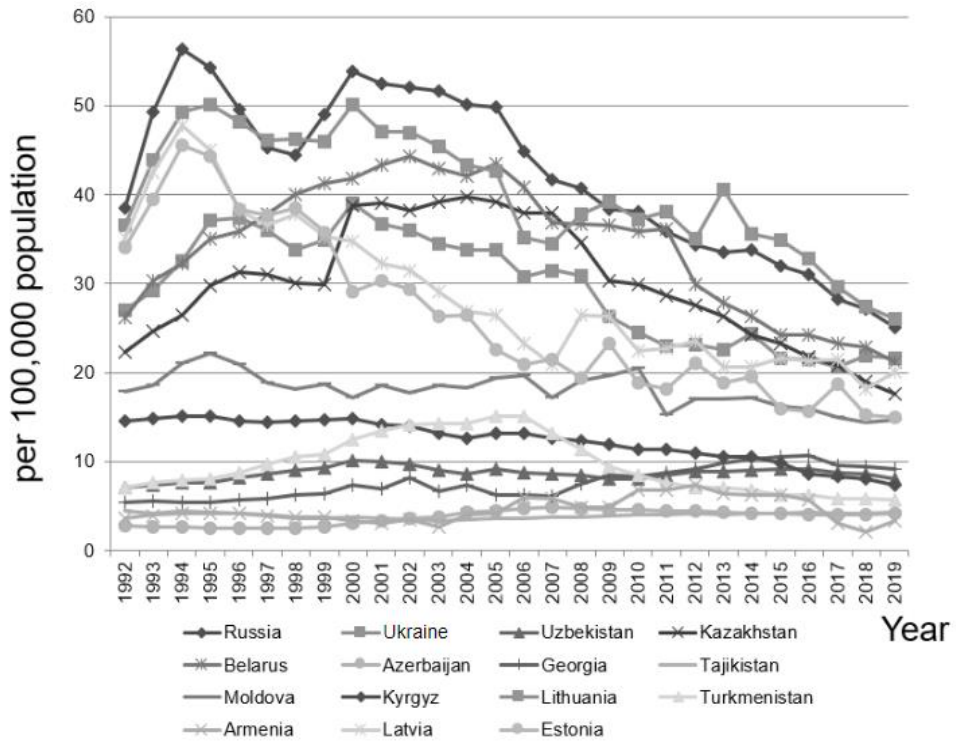
Figure 1. The annual suicide rate among all individuals in the 15 post-Soviet countries during the 28-year period from 1992 to 2019.